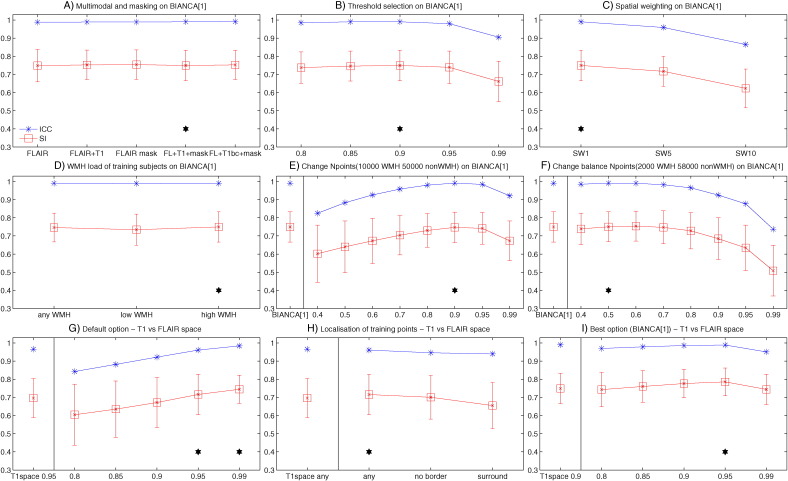
BIANCA optimisation phase II (A-F) and choice of reference modality (G-I) (Dataset 1). The plots show the values of the main metrics used to evaluate BIANCA performance using different values (x axis) for the different options (please refer to the supplementary material and supplementary Table S2 for details about the options). The similarity index (SI) is shown in red, with mean value (square marker) and standard deviation (error bars) across subjects. The intra class correlation coefficient (ICC) between the total WMH volume from BIANCA output and manual segmentation is shown in blue. The black stars indicate the optimal alternative options for the specific optimisation step.